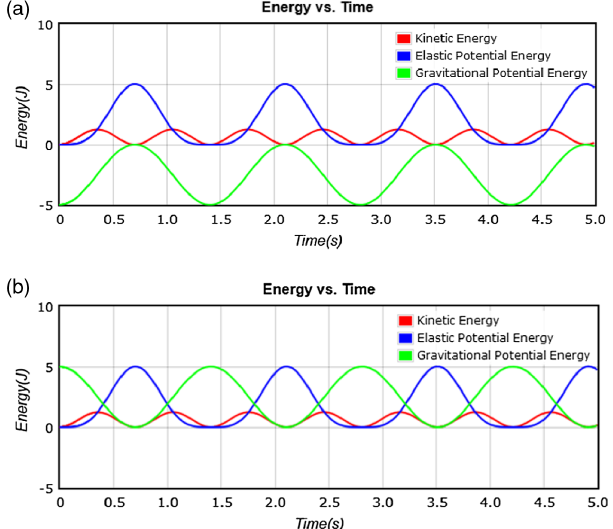
FIG. 6. (a) Incorrect graph and (b) correct graph of energies in a vertical spring-mass system